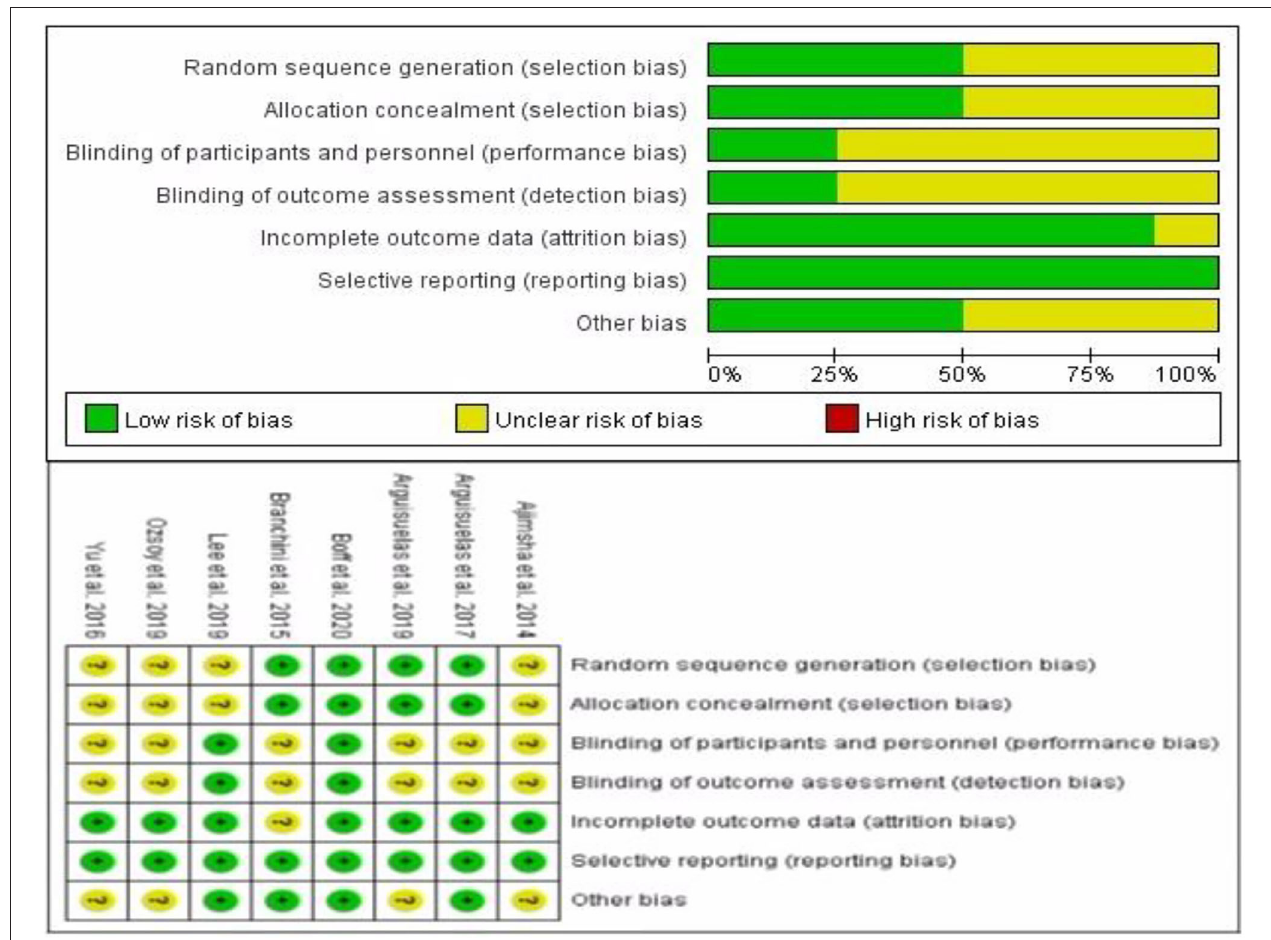
FIGURE 2 | Risk of bias graph.